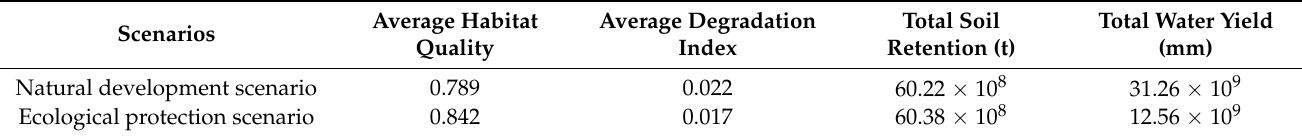
Table 1. Variation in ecosystem services under different scenarios in Nanping in 2025.